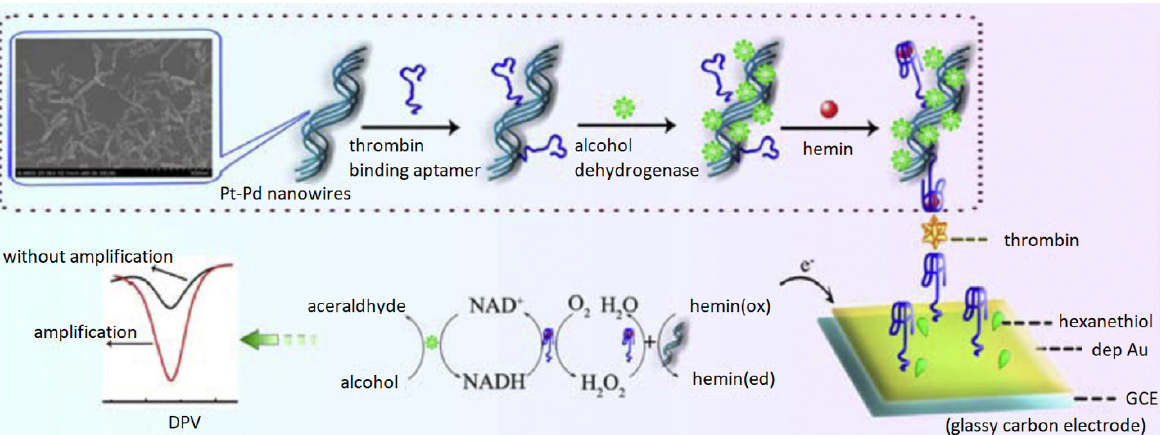
Figure 6. Pt-Pd nanowire-based pseudo triple-enzyme electrochemical aptasensor for thrombin detection. Adapted from [80].